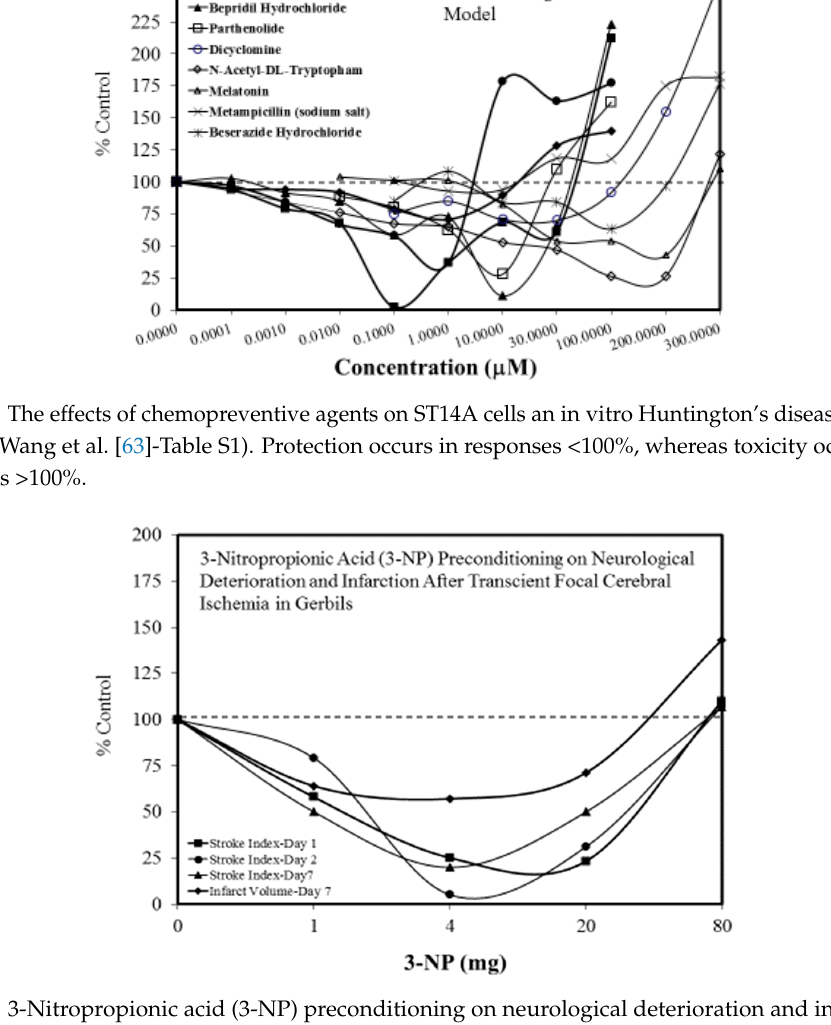
Figure 9. 3-Nitropropionic acid (3-NP) preconditioning on neurological deterioration and infarction after transient focal cerebral ischemia in gerbils (Source: Kuroiwa et al. [68]).